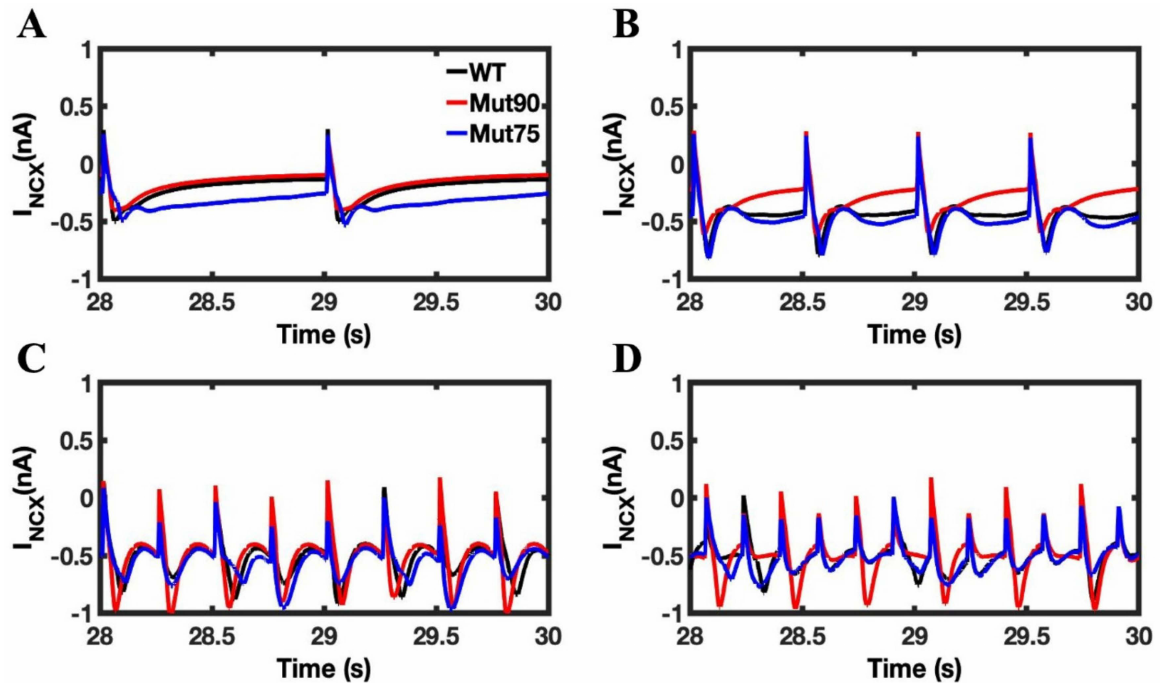
Figure 15. Na + -Ca 2+ exchanger calcium current in myocyte simulations under beta-adrenergic stimulation. ( A ) Na + -Ca 2+ exchanger current at 1 Hz pacing. ( B ) Na + -Ca 2+ exchanger current at 2 Hz pacing. ( C ) Na + -Ca 2+ exchanger current at 4 Hz pacing. ( D ) Na + -Ca 2+ exchanger current at 6 Hz pacing. The wild-type cardiac myocytes (black) show consistent morphology with increased pacing. The mutant simulations CDI (75% of transition rate—blue and 90% of transition rate—red) of the cardiac myocyte show that the currents through the Na + -Ca 2+ exchanger in the cell membrane becomes destabilized in mutant beta-adrenergic stimulation, as the increased calcium prevents the current to reach the initial diastolic